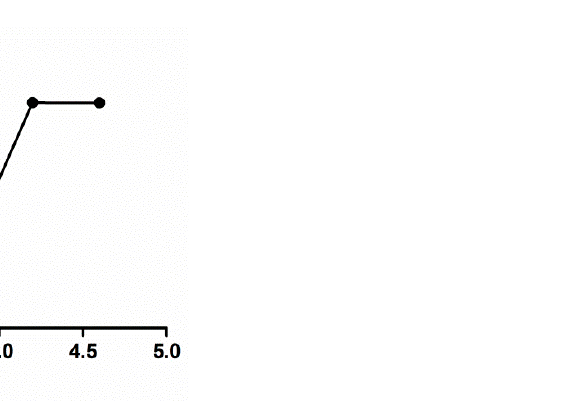
Figure 1. Effect of the pH on extracted grape seed meal protein precipitation. Each value is the mean of triplicate measurements.